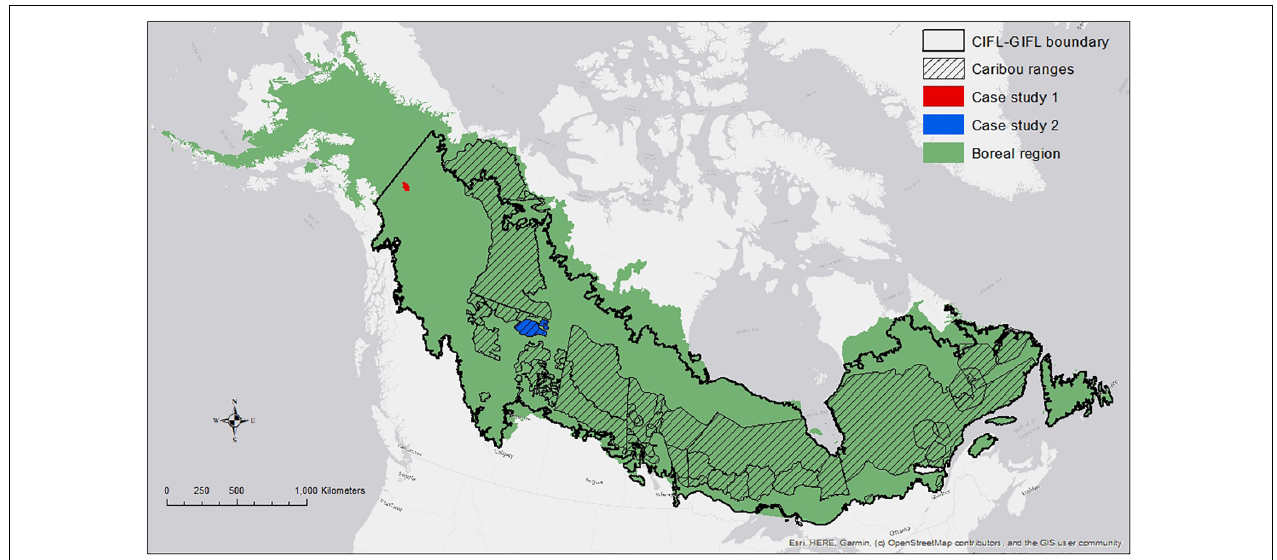
FIGURE 1 | Extent of boreal region, including boreal and boreal alpine zones, in North America (Brandt, 2009). The solid black line indicates the area of intersection of the eight intactness and human influence maps while the crosshatch pattern indicates the limits of the 51 caribou ranges that make up the 2015 BEAD dataset (Pasher et al., 2013). The locations of case studies 1 and 2 are indicated by the red and blue polygons,